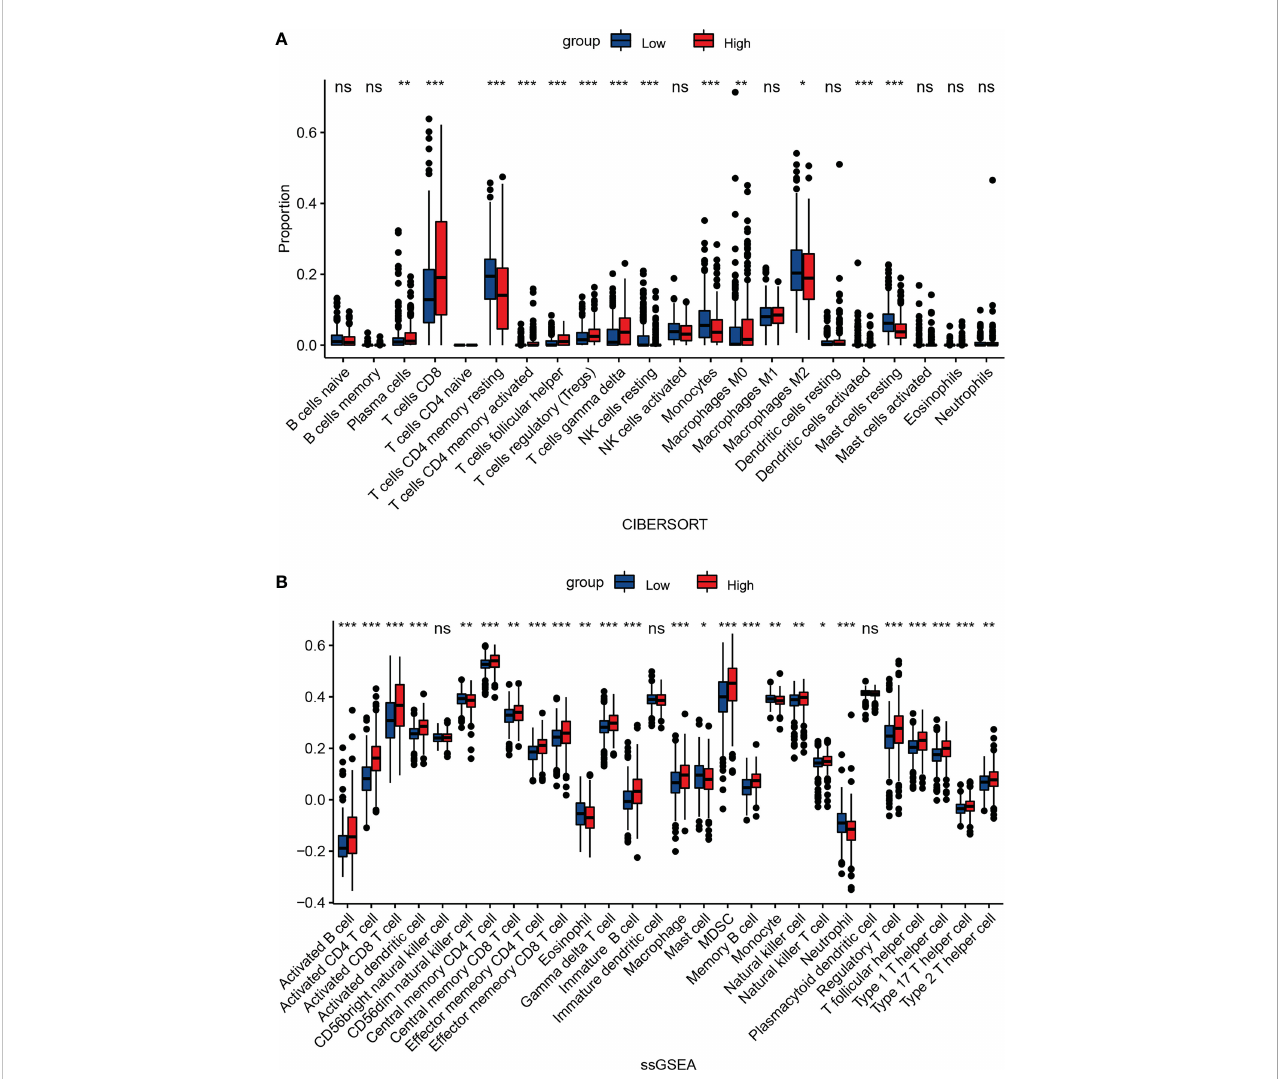
FIGURE 7 Association between NEIL3 expression and immune in fi ltration level. Comparison of the proportion of 22 immune cells (A) and expression levels of 28 immune cells (B) between NEIL3-high and -low groups by CIBERSORT and ssGSEA, respectively. ns, P ≥ 0.05; *, P < 0.05; **, P < 0.01; ***, P <